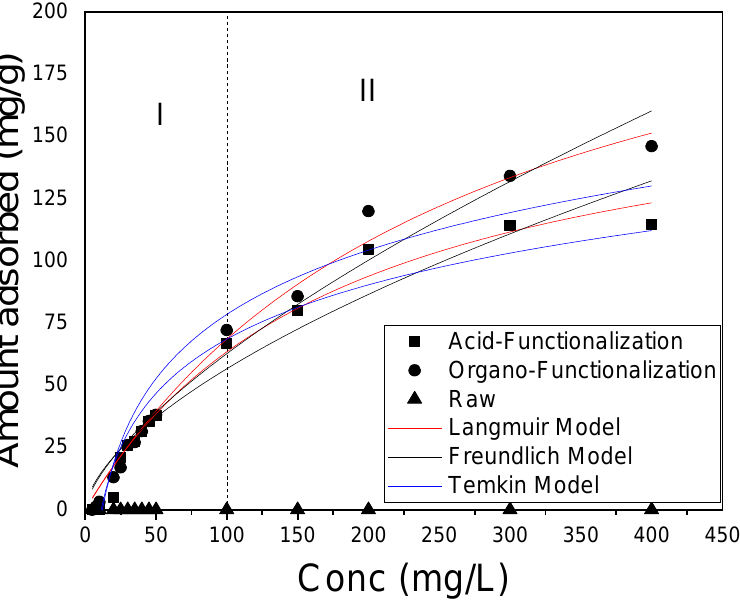
Figure 9. Representation of fit for raw and functionalized samples to the Langmuir isotherm models; Freundlich and Temkin (m = 0.05 g, pH = 6, time = 4 h at 25 °C with 200 rpm rotation) .